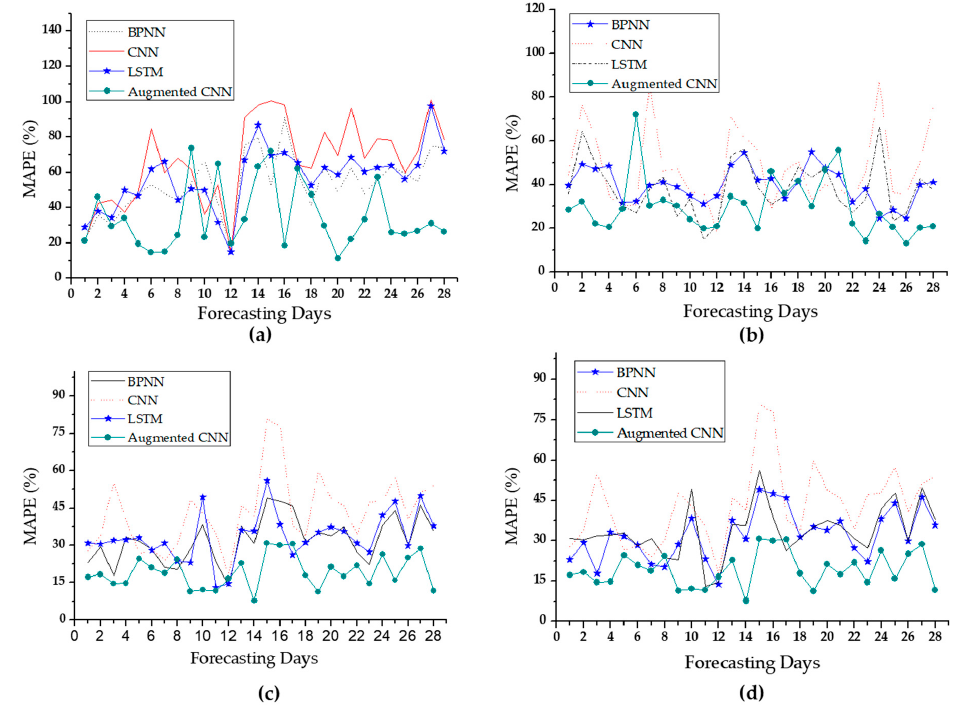
Figure 9. Daily average of MAPE of higher uncertain households from Table 3: ( a ) household 10; ( b ) household 8; ( c ) household 9 and ( d ) household 1.